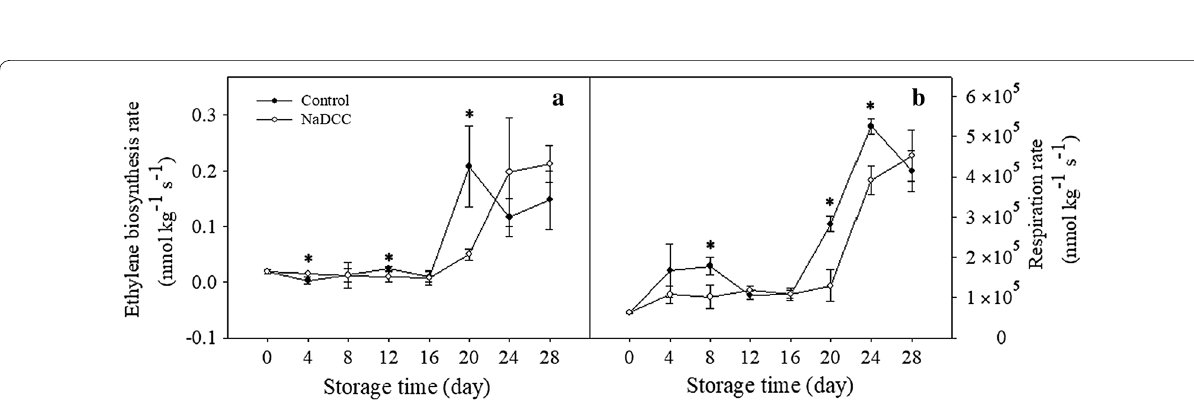
Fig. 4 Changes of ethylene biosynthesis rate ( a ) and respiration rate ( b ) of the stored banana fruit. Data presented are means (from three separate groups) standard errors (n 3). The asterisks above bars represent a significant difference ( p < ± =